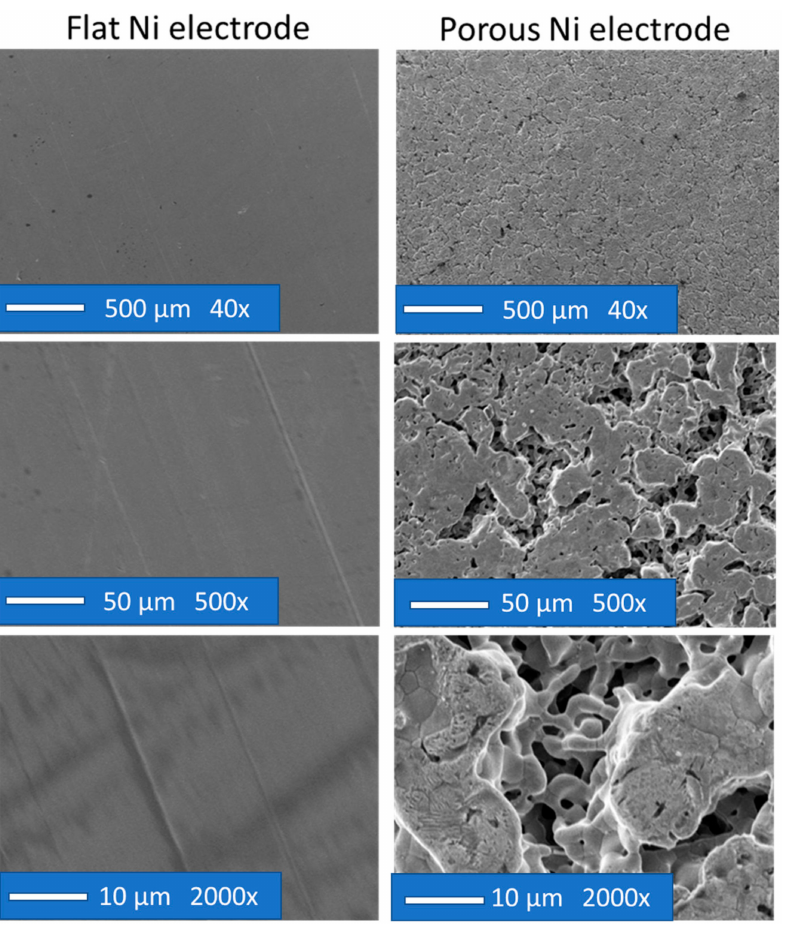
Figure 3. SEM micrographs of the flat Ni sample (left) and porous Ni electrode (right) under different magnifications: 40 × , 500 × and 2000 ×